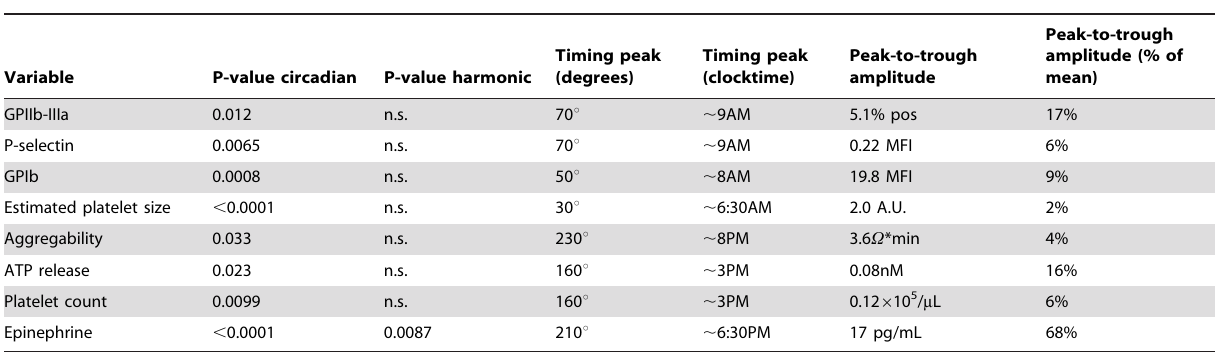
Table 1. Endogenous circadian rhythms in platelet function from cosinor analyses.